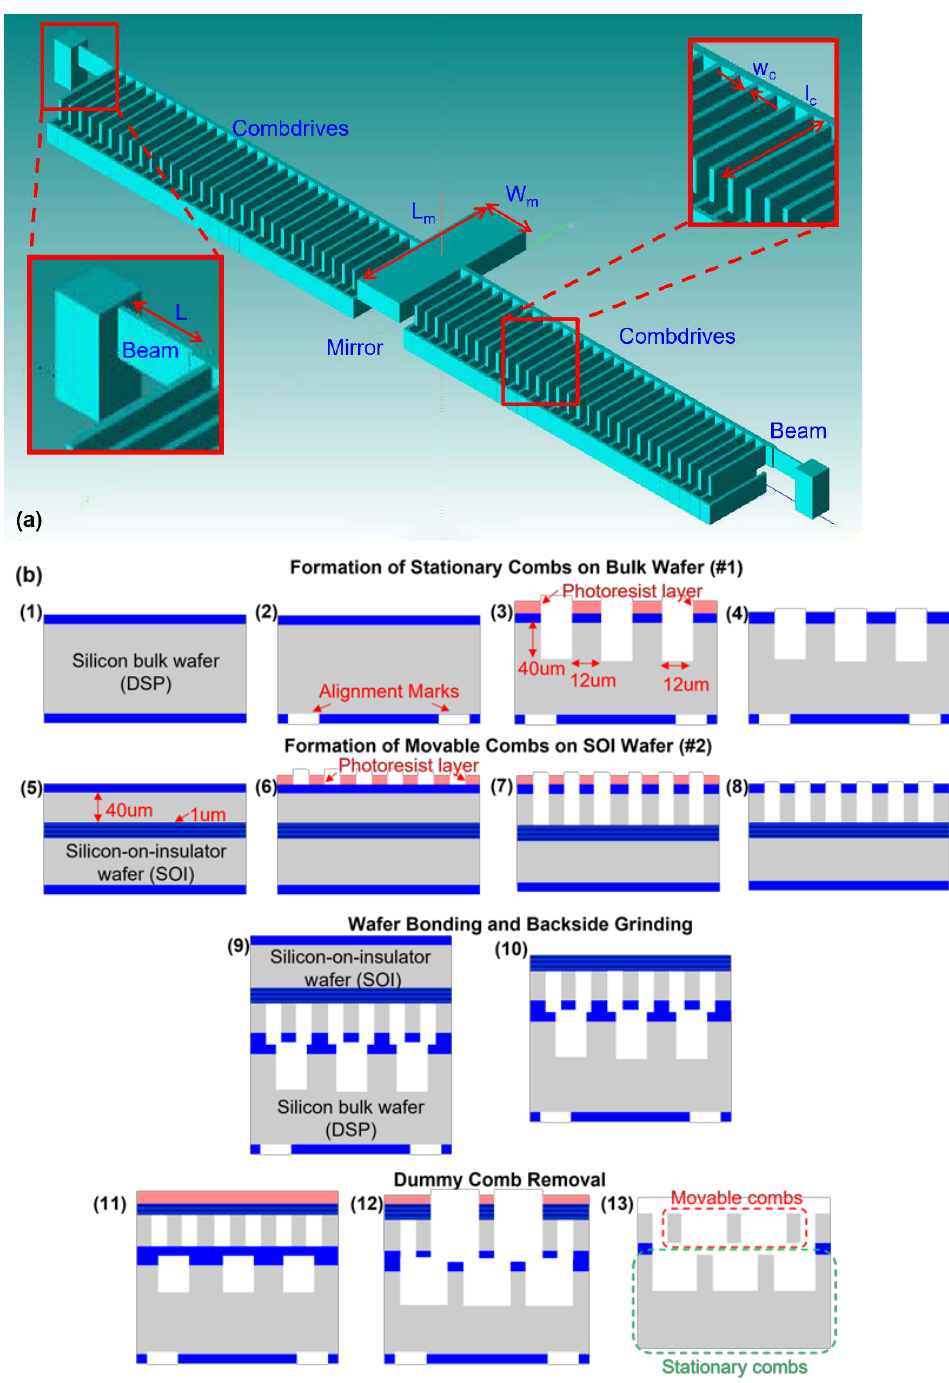
Figure 1. Schematic of ( a ) the 3D comb drive structure and ( b ) process flow of the CMOS-compatible fabrication